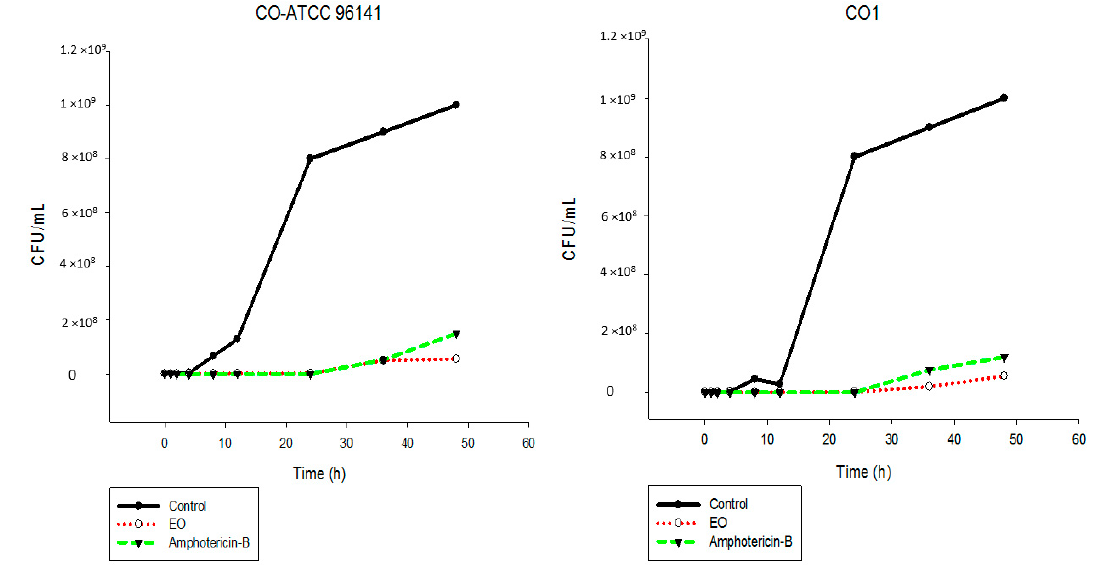
Figure 7. Time-kill curves of C. orthopsilosis ATCC 96141 and CO1 following exposure to the essential oil of C. nardus and amphotericin-B. Control represents the untreated Candida cells.